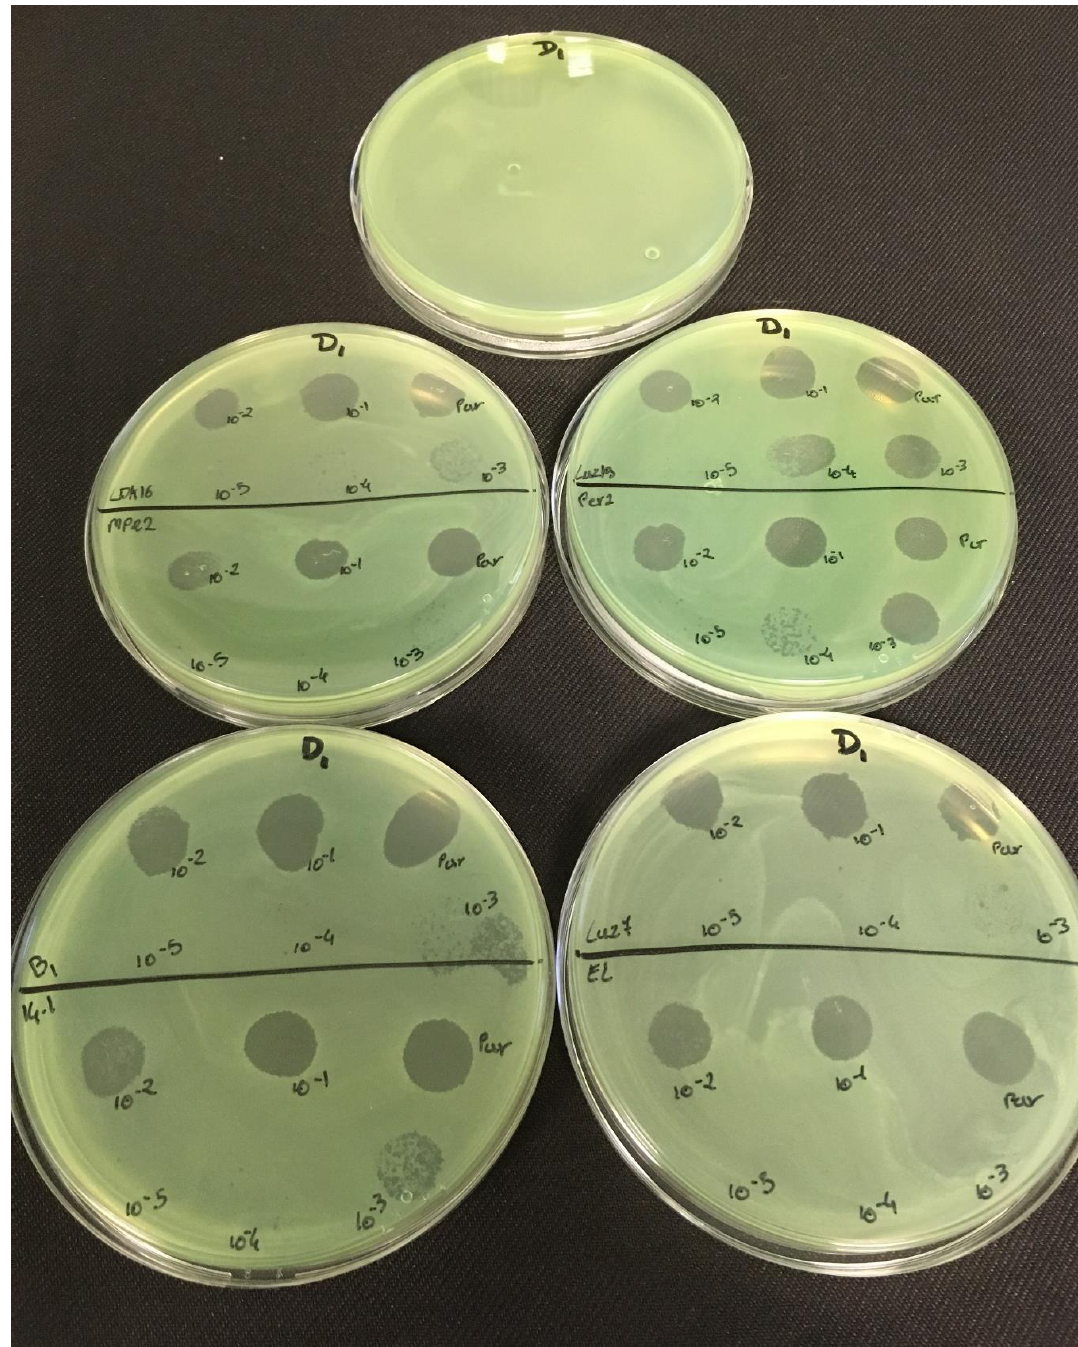
Figure A3. Plaque lysis forming from one spot test assay on the D1 isolate with diluted phage suspensions. Each plate corresponds to plaque lysis from two tested phages. The first plate at the top of the picture corresponds to the growth control of the isolate without phages.